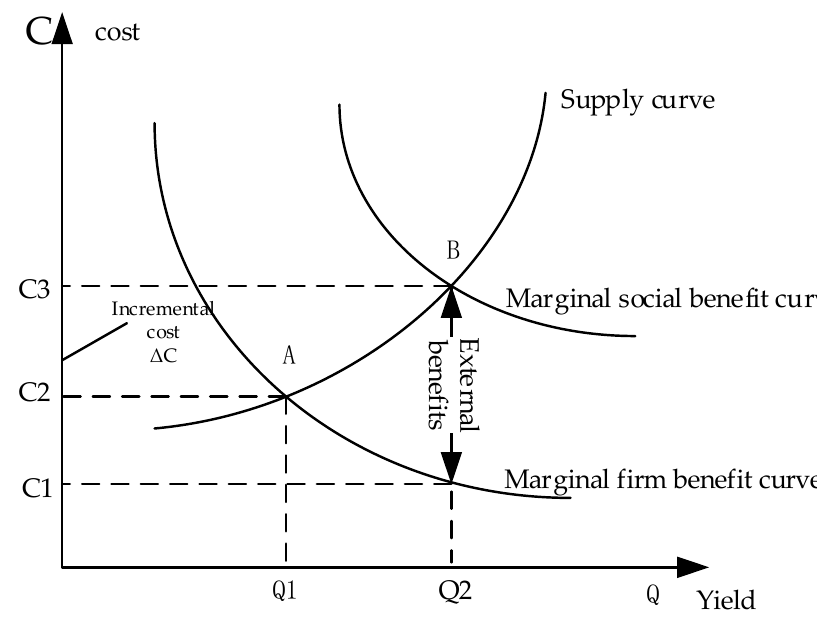
Figure 2. Externality analysis of prefabricated buildings.